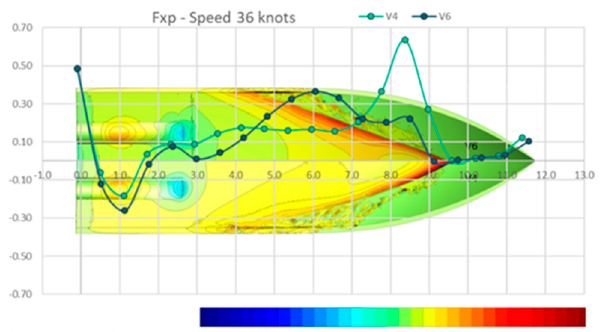
Figure 7. Comparison of pressure distribution on the hull bottom for V1 and V6 at different speeds.